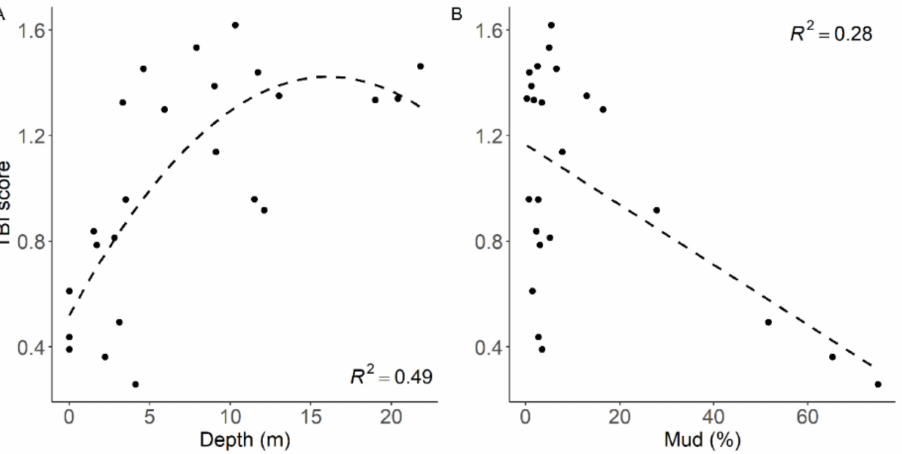
Figure 8. Regression plots of TBI scores versus ( A ) water column depth and ( B ) sediment mud